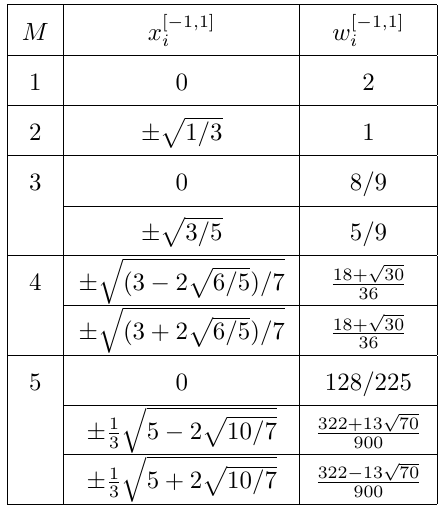
Table 1 . Nodes and weights of the Gauss-Legendre